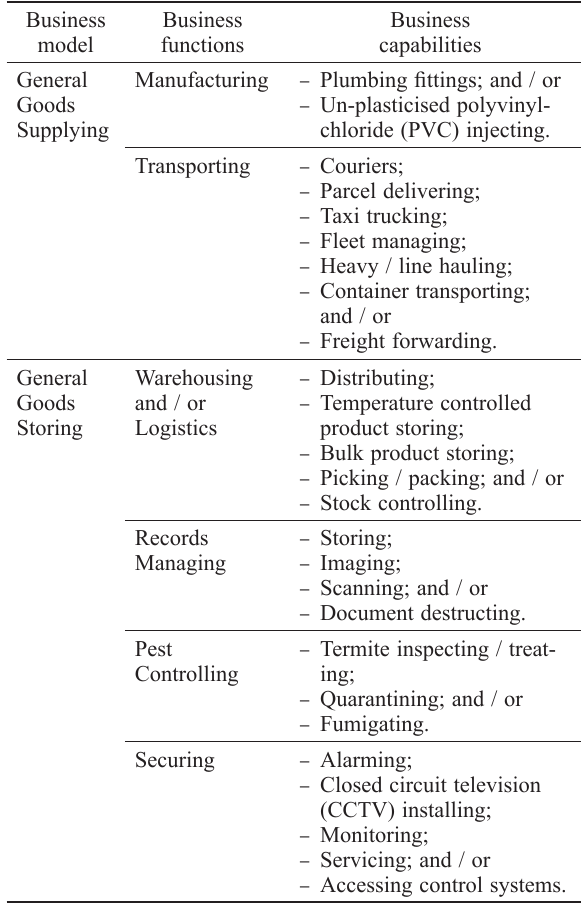
Table 4. Matrix of organisation three business functions and capabilities Business Business model